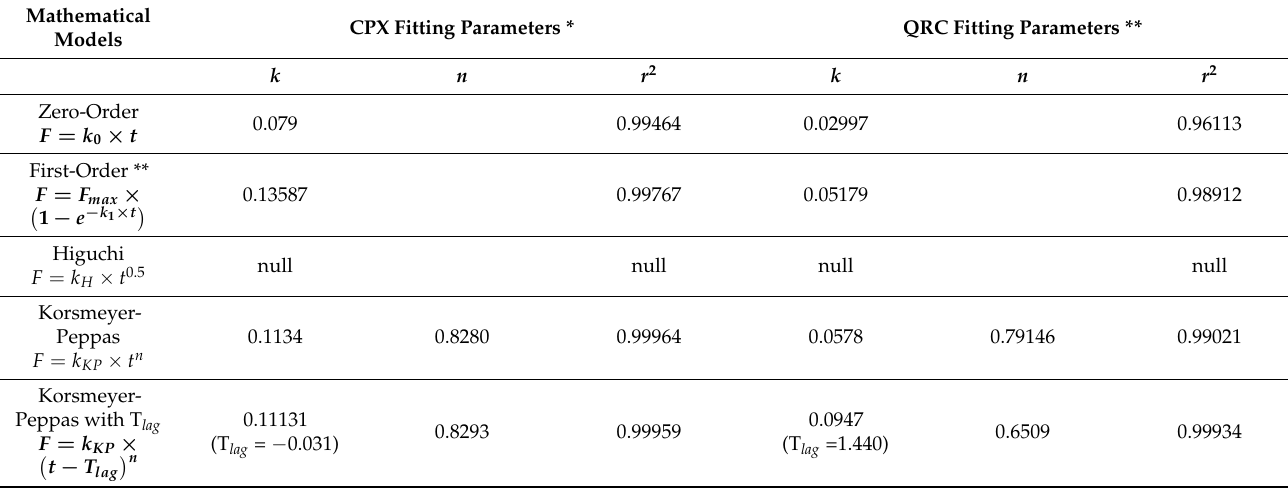
Figure 8. CPX dose fraction released from BioQ-CPX ( (cid:4) ) as a function of incubation time, curve- fitted with the First Order (blue line), Zero Order (green line), and Korsmeyer–Peppas (red line) mathematical models; means ± SE ( n = 6). Table 8. Mathematical models fitted to the experimental QRC and CPX release curves: calculated fitting parameters and square of correlation coefficient (R 2